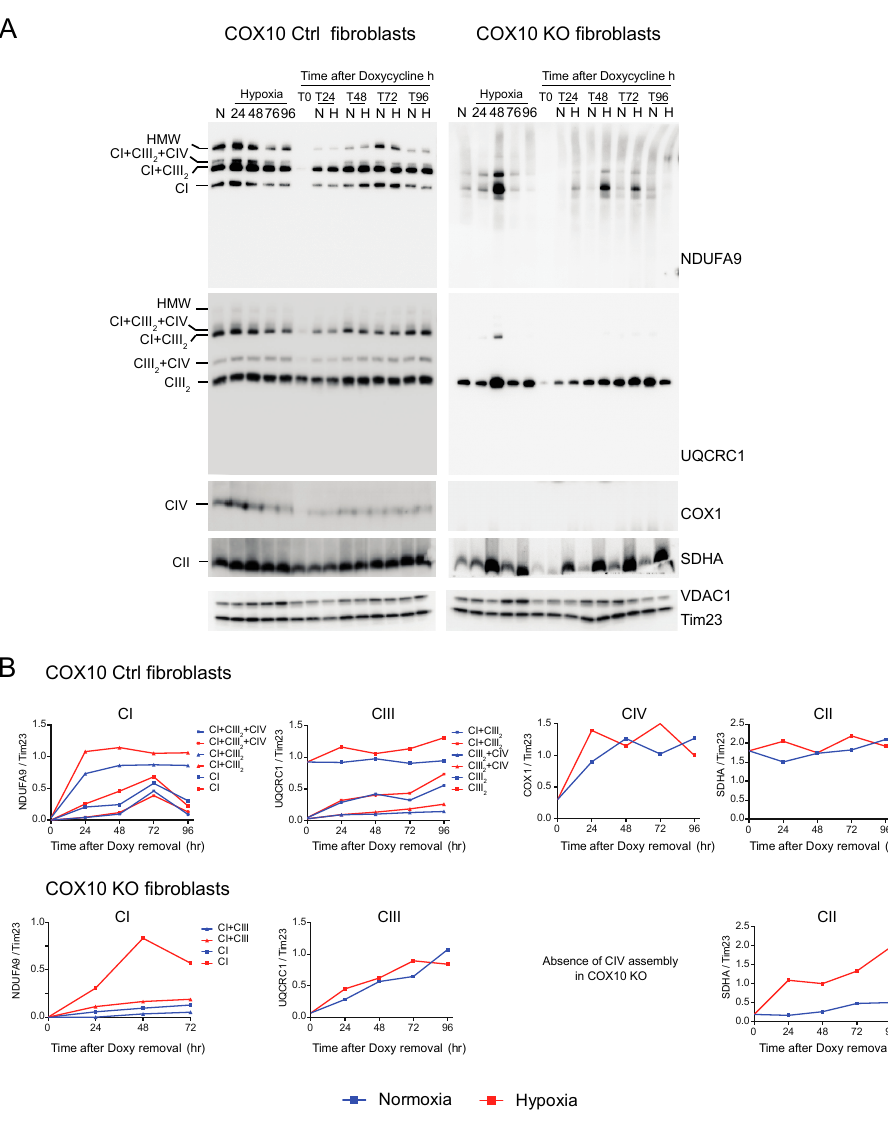
Figure 7. Respiratory complex and supercomplex de novo assembly in normoxia and hypoxia in COX10 fibroblasts after doxycycline treatment. ( A ) COX10 control and KO skin fibroblasts were treated with 15 μ g/mL doxycycline for 6 days to inhibit mitochondrial protein synthesis and deplete the organelle of respiratory complexes. The drug was removed (time 0, T0) and cells were exposed in parallel to either normoxia (N, 21% oxygen) or hypoxia (H, 1% oxygen) for different times: 24, 48, 72 and 96 h (T24, T48, T72 and T96 respectively). As a control, untreated fibroblasts were exposed for the different times to hypoxia (24 to 96 h). Respiratory complexes were analyzed by BN-PAGE followed by Western blotting. In three identical blots, the antibodies were sequentially added in the following order, on blot 1: NDUFA9 (CI subunit), ATP5A (CV subunit) and COX1 (CIV subunit) and on blot 2: UQCRC1 (CIII subunit), and on blot 3: SDHA (CII subunit). Tim23 and VDAC1 used as loading control. ( B ) The graphs represent the kinetics of assembly of CI, CIII, CIV and CII calculated at the di ff erent time points after respiratory complexes depletion by normalizing the NDUFA9, UQCRC1, COX1 and SDHA signal to Tim23 under normoxia (blue) or hypoxia (red) from Western blots shown in ( A ) using ImageJ software ( n = 1). In COX10 KO fibroblasts, there is no CIV assembly, so there is no graph for this complex. In the KO fibroblasts, assembly of CI and CII, but not CIII, was enhanced over time in 1% oxygen compared to the same time in normoxia. In control skin fibroblasts, no di ff erence was observed in the de novo assembly between normoxia and